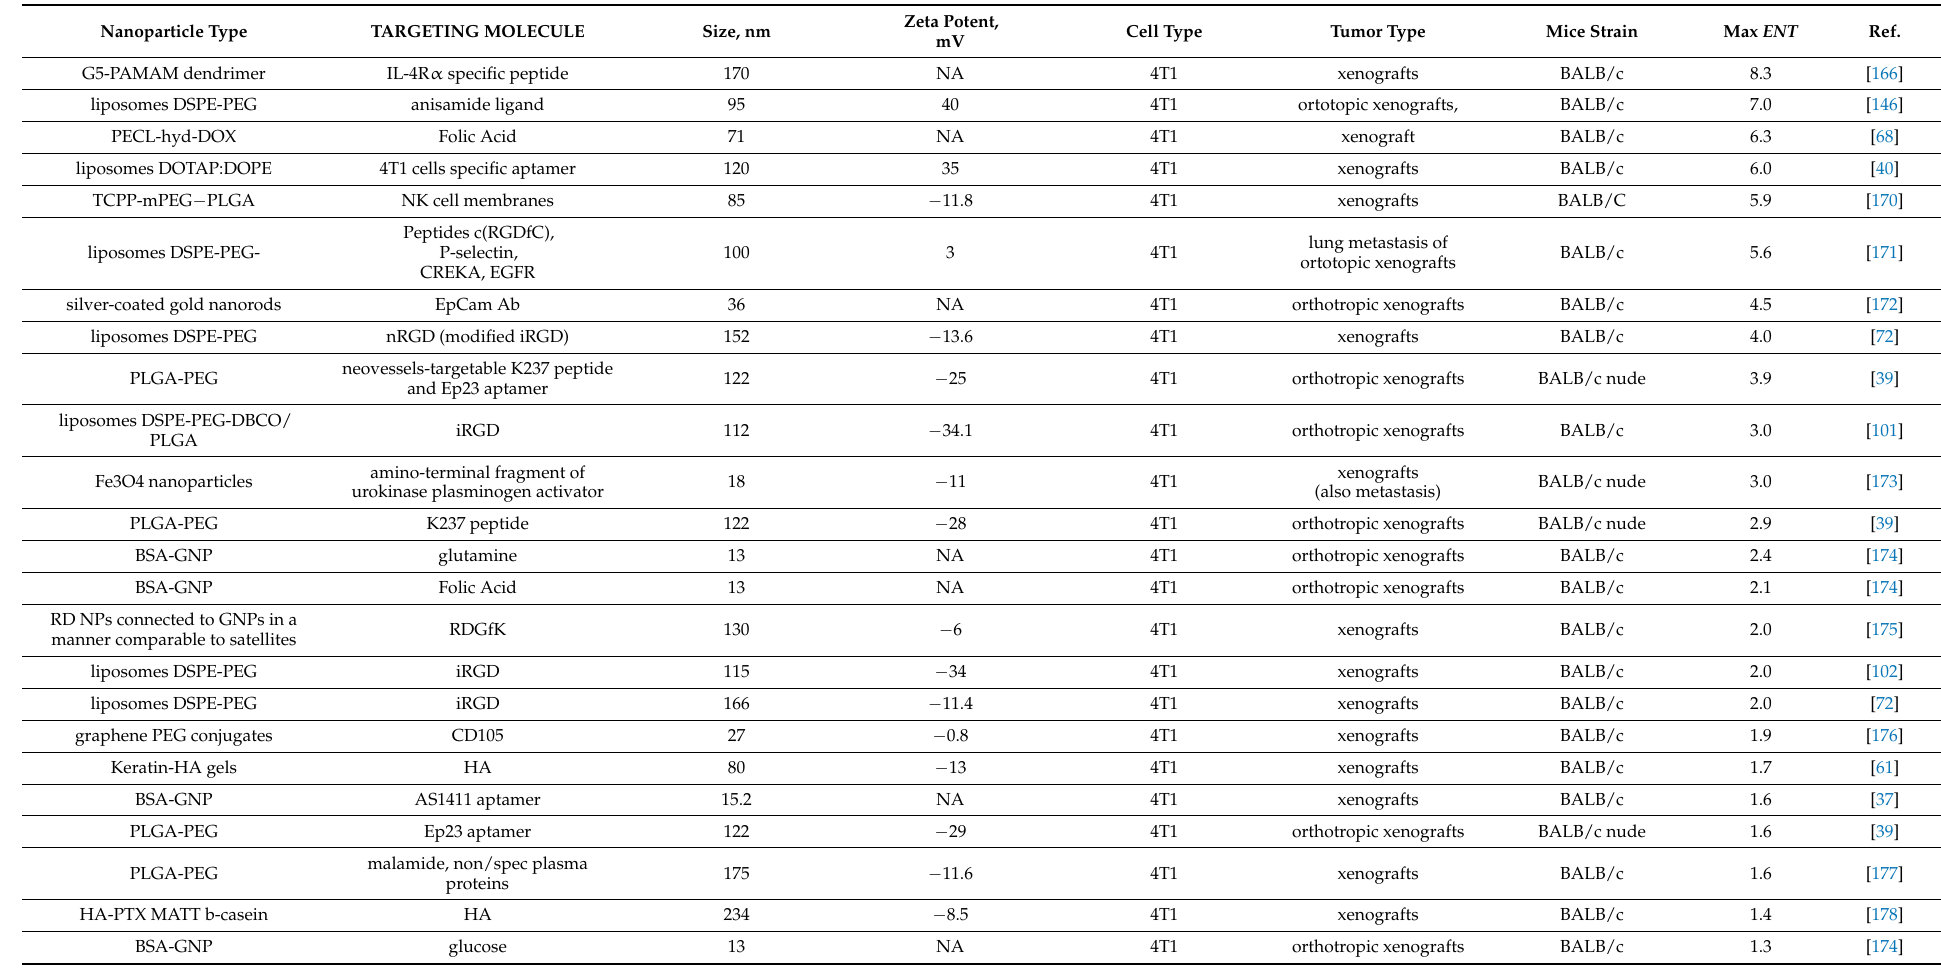
Table 5. Nanoparticles targeted by different molecules in 4T1 breast cancer xenografts. The table is sorted by the maximum ENT